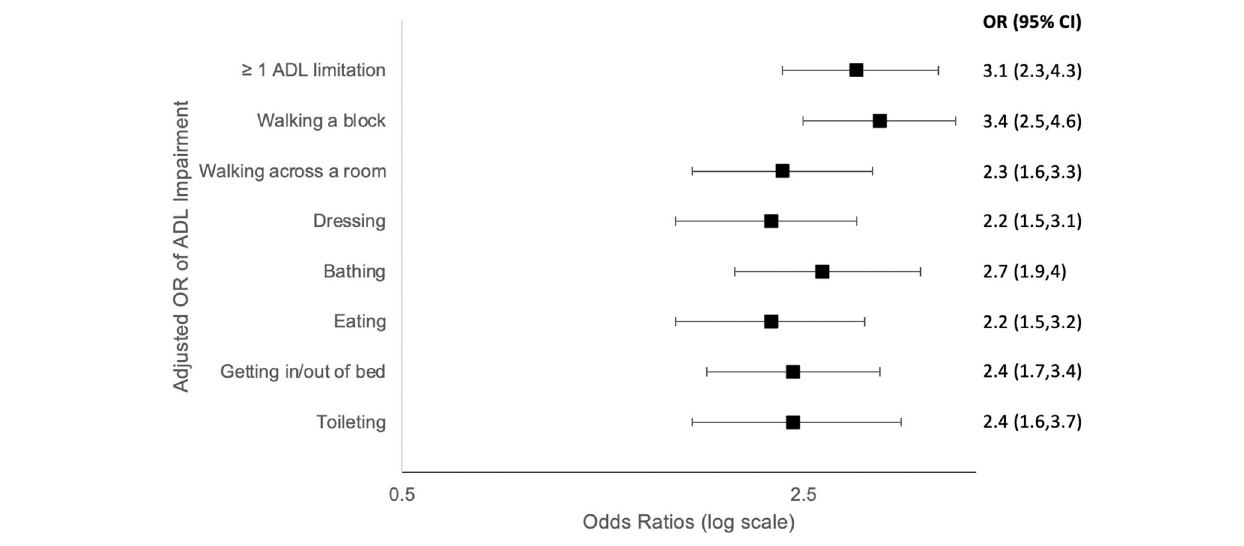
FIGURE 1 | Forest plots (odds ratios with 95% confidence intervals) based on Multivariate Logistic regression models comparing activities of daily living (ADL) impairment among US older adults with vs. without COPD by self-report. OR, odds ratio; ADL, activities of daily living; Adjusted model: adjusted for age, gender, race/ethnic group, and